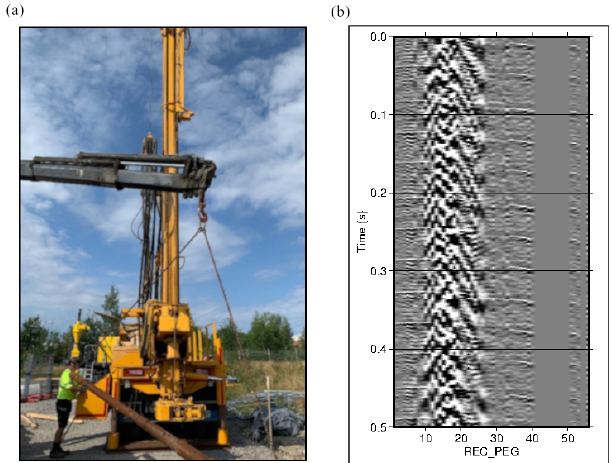
Figure 2. Hammer drilling at the I-EDDA test site in Örebro, Swe- den (see Fig. 1) in August 2020 (a) ; Raw shot gather showing strong rig-generated noise near station 17. The seismic line contained 56 channels, but only receivers 1–40, 51–53 and 56 were active during the recording (b) .